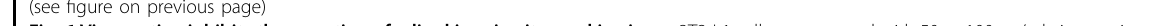
Fig. 6 Vinpocetine inhibits the secretion of adipokines in vitro and in vivo. a 3T3-L1 cells were treated with 50 or 100 μ g/ml vinpocetine on day 2 after inducing differentiation, and cell lysates were harvested at the 6, 12, and 24-h time points. The mRNA expression of Il-10, IL-6, and IFN- α was detected by qPCR analysis. β -actin was used as a normalization control. b Vinpocetine was administered to both the HFD-fed and NFD-fed mice, as described in the “ Materials and methods ” . Gonadal WAT and inguinal WAT were collected, and tissue lysates were prepared as described in the “ Materials and methods ” . The mRNA expression of IL-10, IL-6, and IFN- α was detected by qPCR analysis. β -actin was used as a normalization control. Data are presented as the mean ± SD; * P < 0.05 and *** P < 0.001 for untreated control vs. 50 and 100 μ g/ml vinpocetine. Data are presented as the mean ± SD ( n = 4 for NFD-fed mice and n = 8 for HFD-fed mice); * P < 0.05; ** P < 0.01; and *** P < 0.001 for untreated control vs. 10 and 20